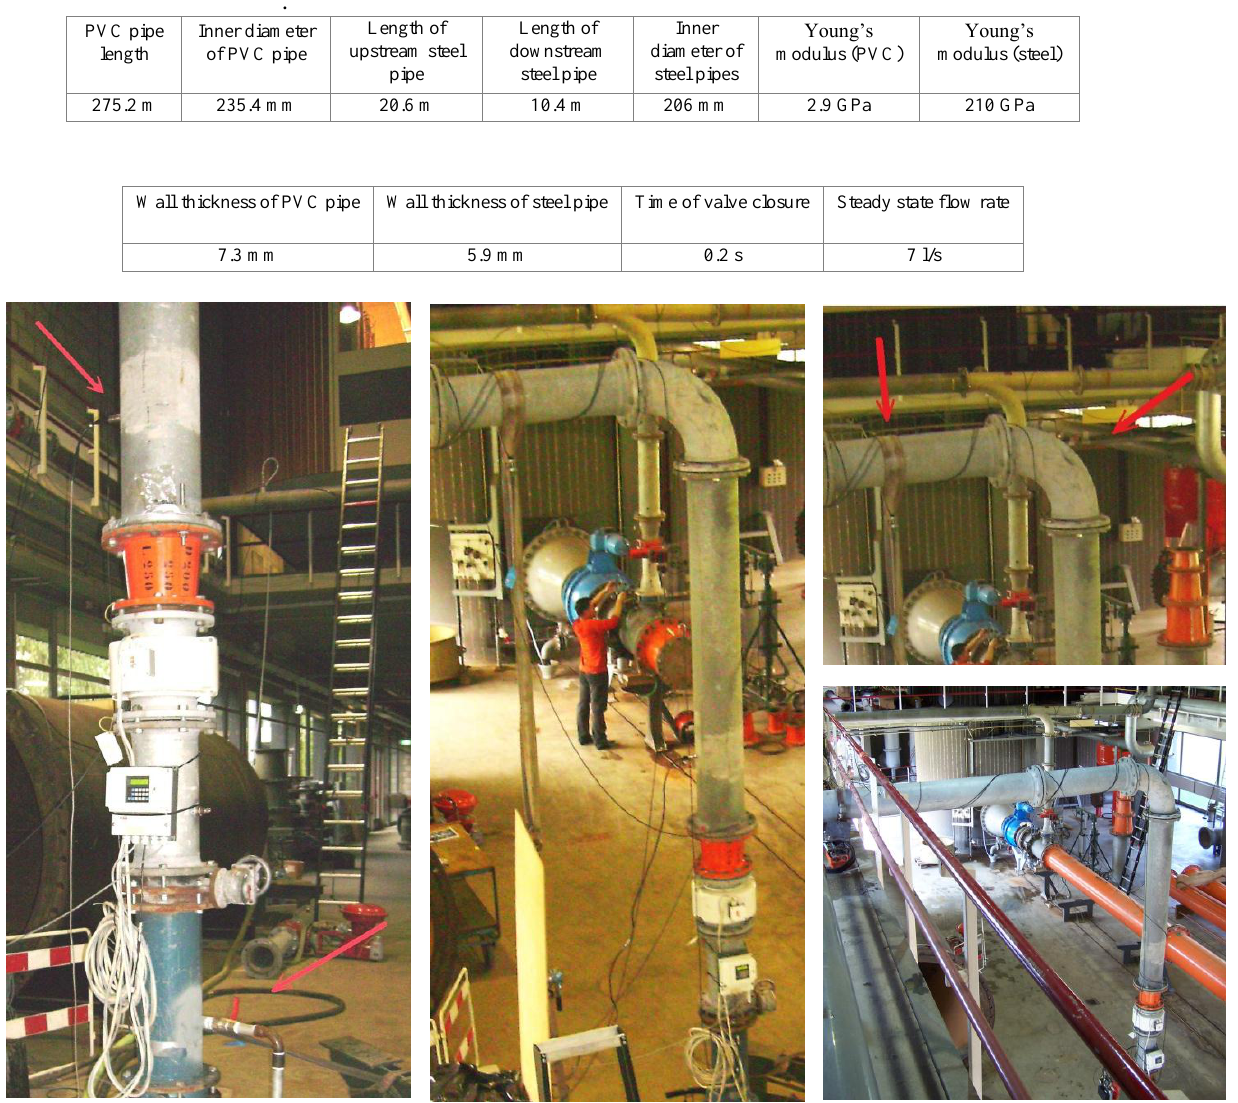
Table 2. Specifications of the PVC pipeline